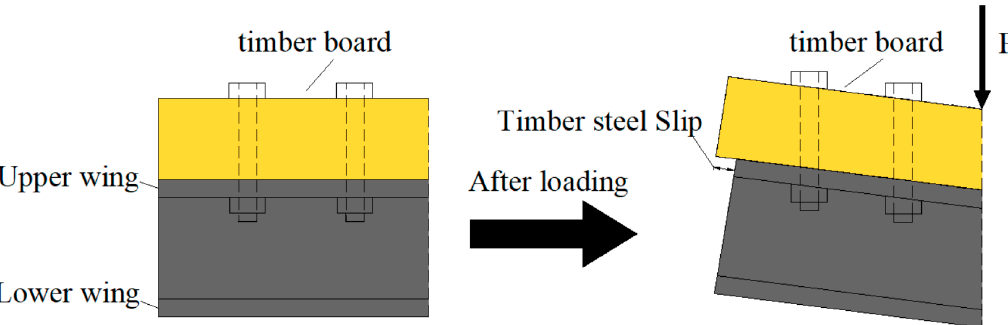
Figure 11. Schematic diagram of slippage. Table 6. Bearing capacity, slip and bolt parameters of the composite beam.